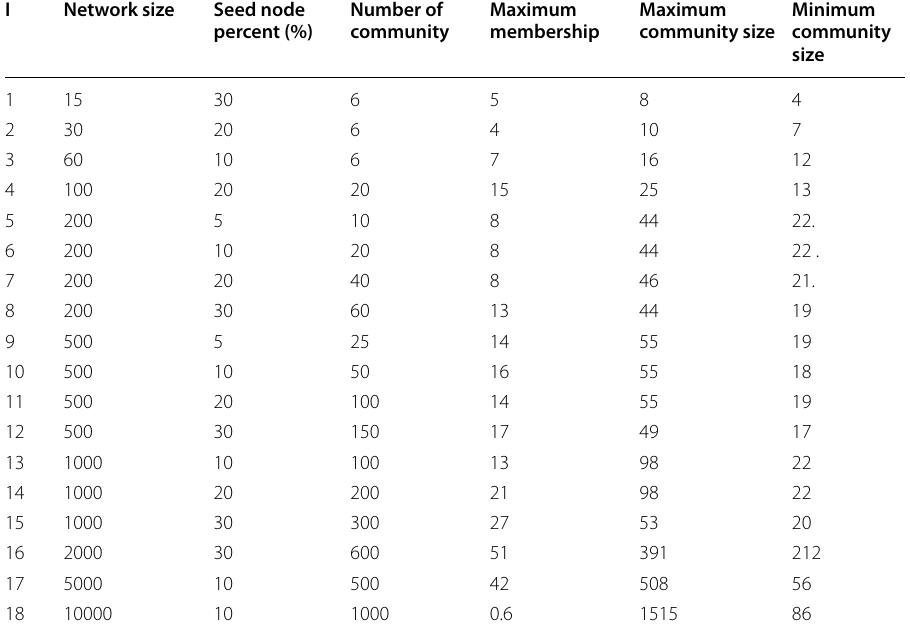
Table 6 Some statistics of Preference Implication-based method results of communities created on the artificial networks from Table 4 and different sizes of seed nodes